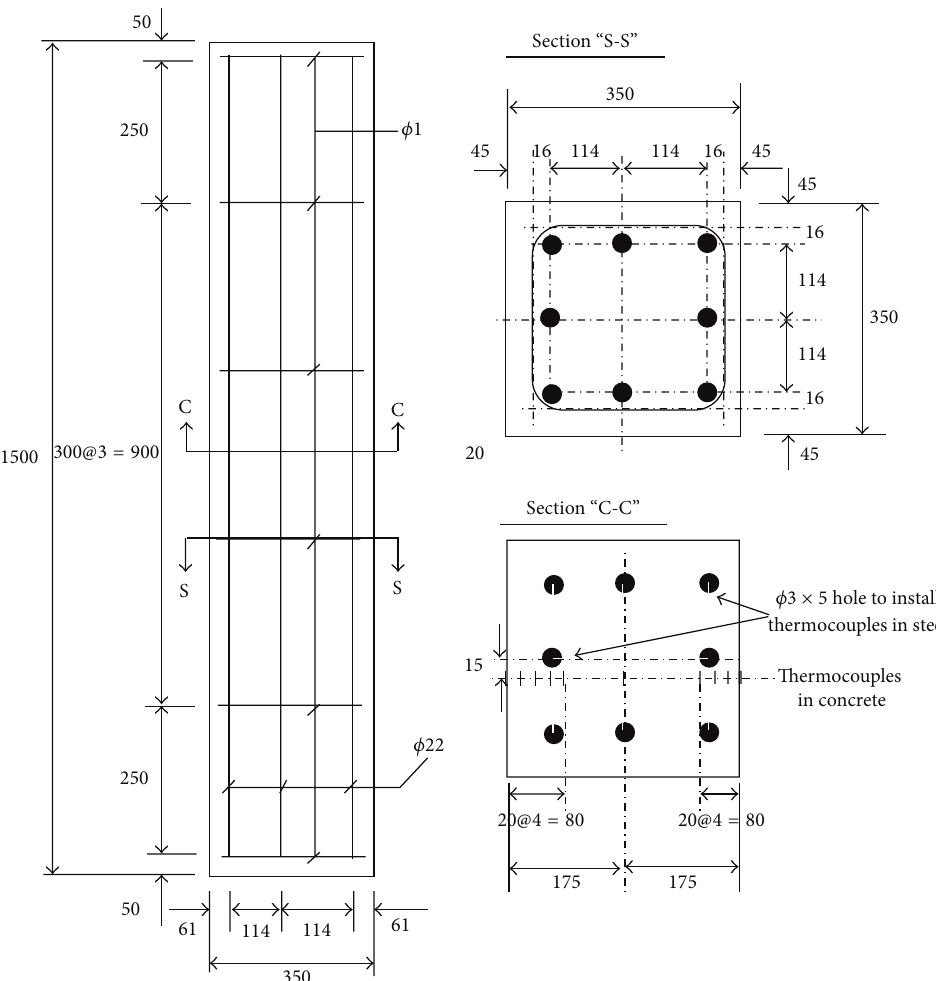
Figure 2: Details of RC column for fire test and locations of thermocouples. All dimensions are in mm.